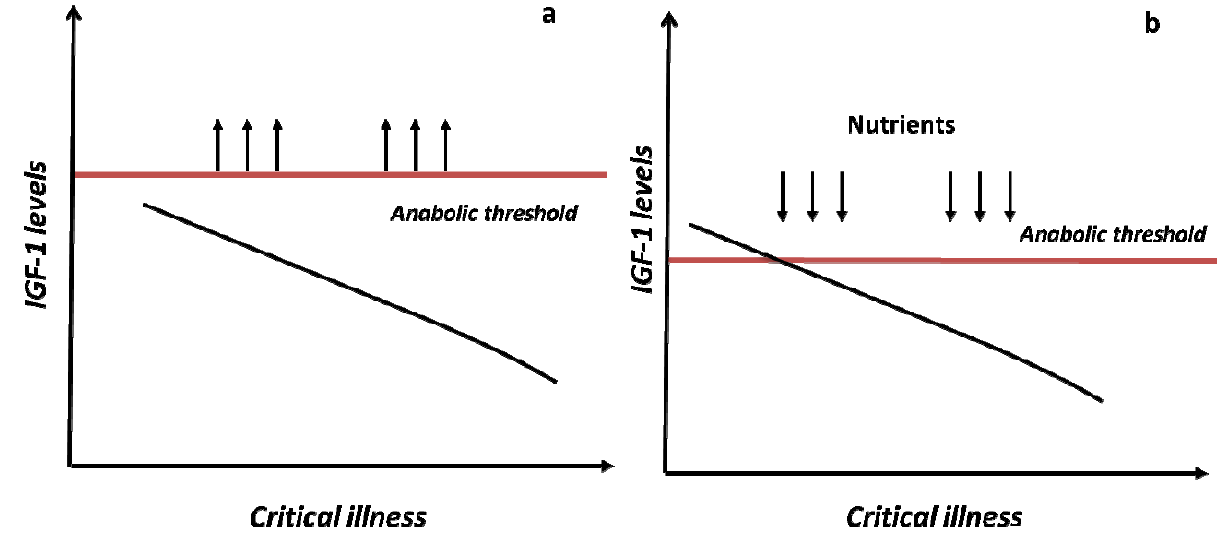
Figure 2. Potential therapeutic implication of mineral supplementation during critical